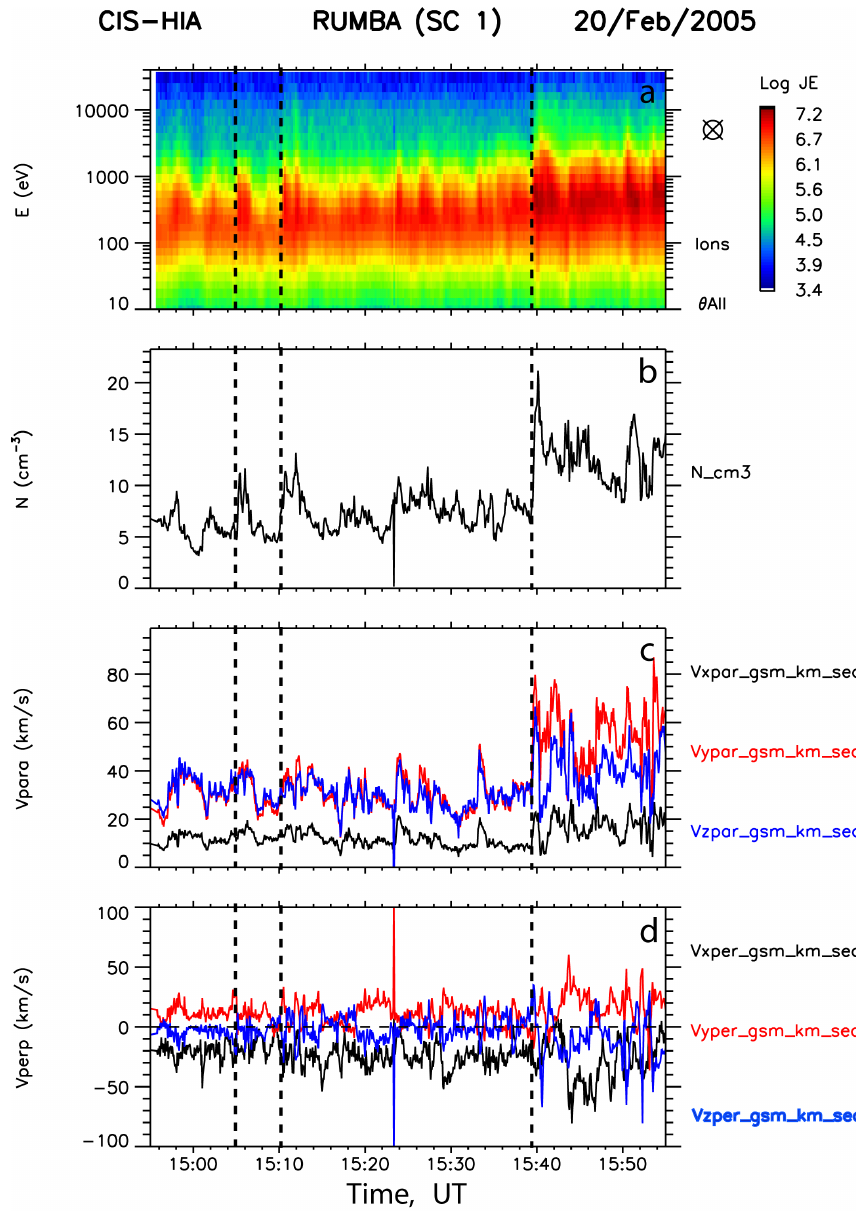
Fig. 3. Overview of the CIS-HIA data of Cluster-1 for the period 14:55–15:55UT. (a) Omnidirectional ion spectrogram. (b) ion density. (c) and (d) X , Y , Z components of the parallel ion velocity and of the perpendicular ion velocity in GSM coordinates. The dashed lines represent the beginning of each